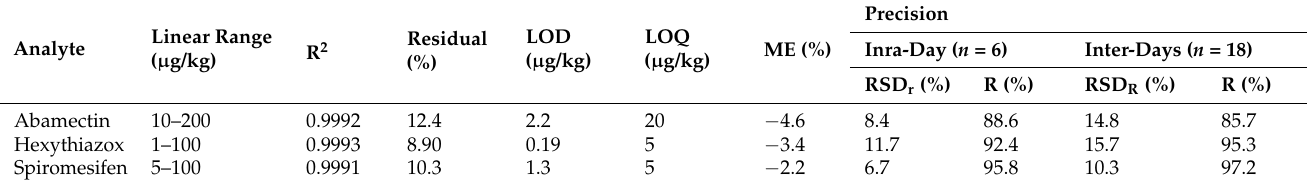
Table 2. Calibrationparameters, LOD,LOQ,ME(%), andprecisionofthethreeacaricidesineggplantfruits.